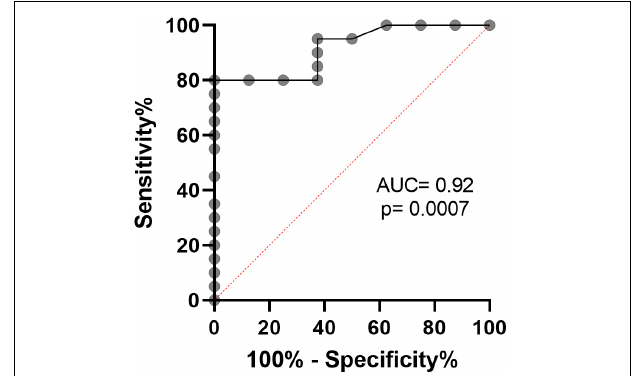
FIGURE 5 | Receiver operating characteristics curve demonstrates that% T-MDSC is associated with need for respiratory support in children with symptomatic COVID. In all children with COVID, admitted to both ICU and the ward, increased % T-MDSC was associated with higher likelihood of requiring